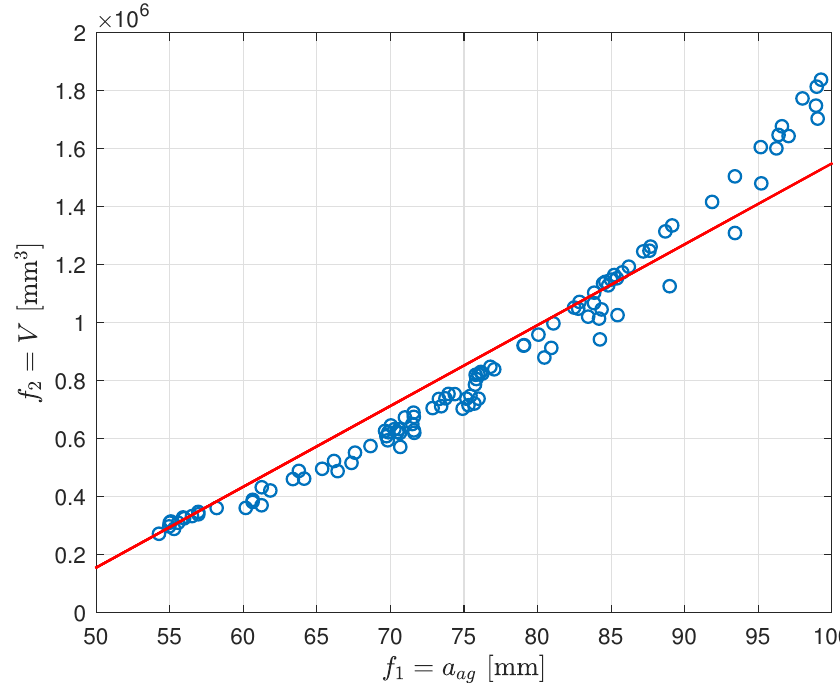
Figure 7. Linear dependency between center distance between sun and planet gear and volume of